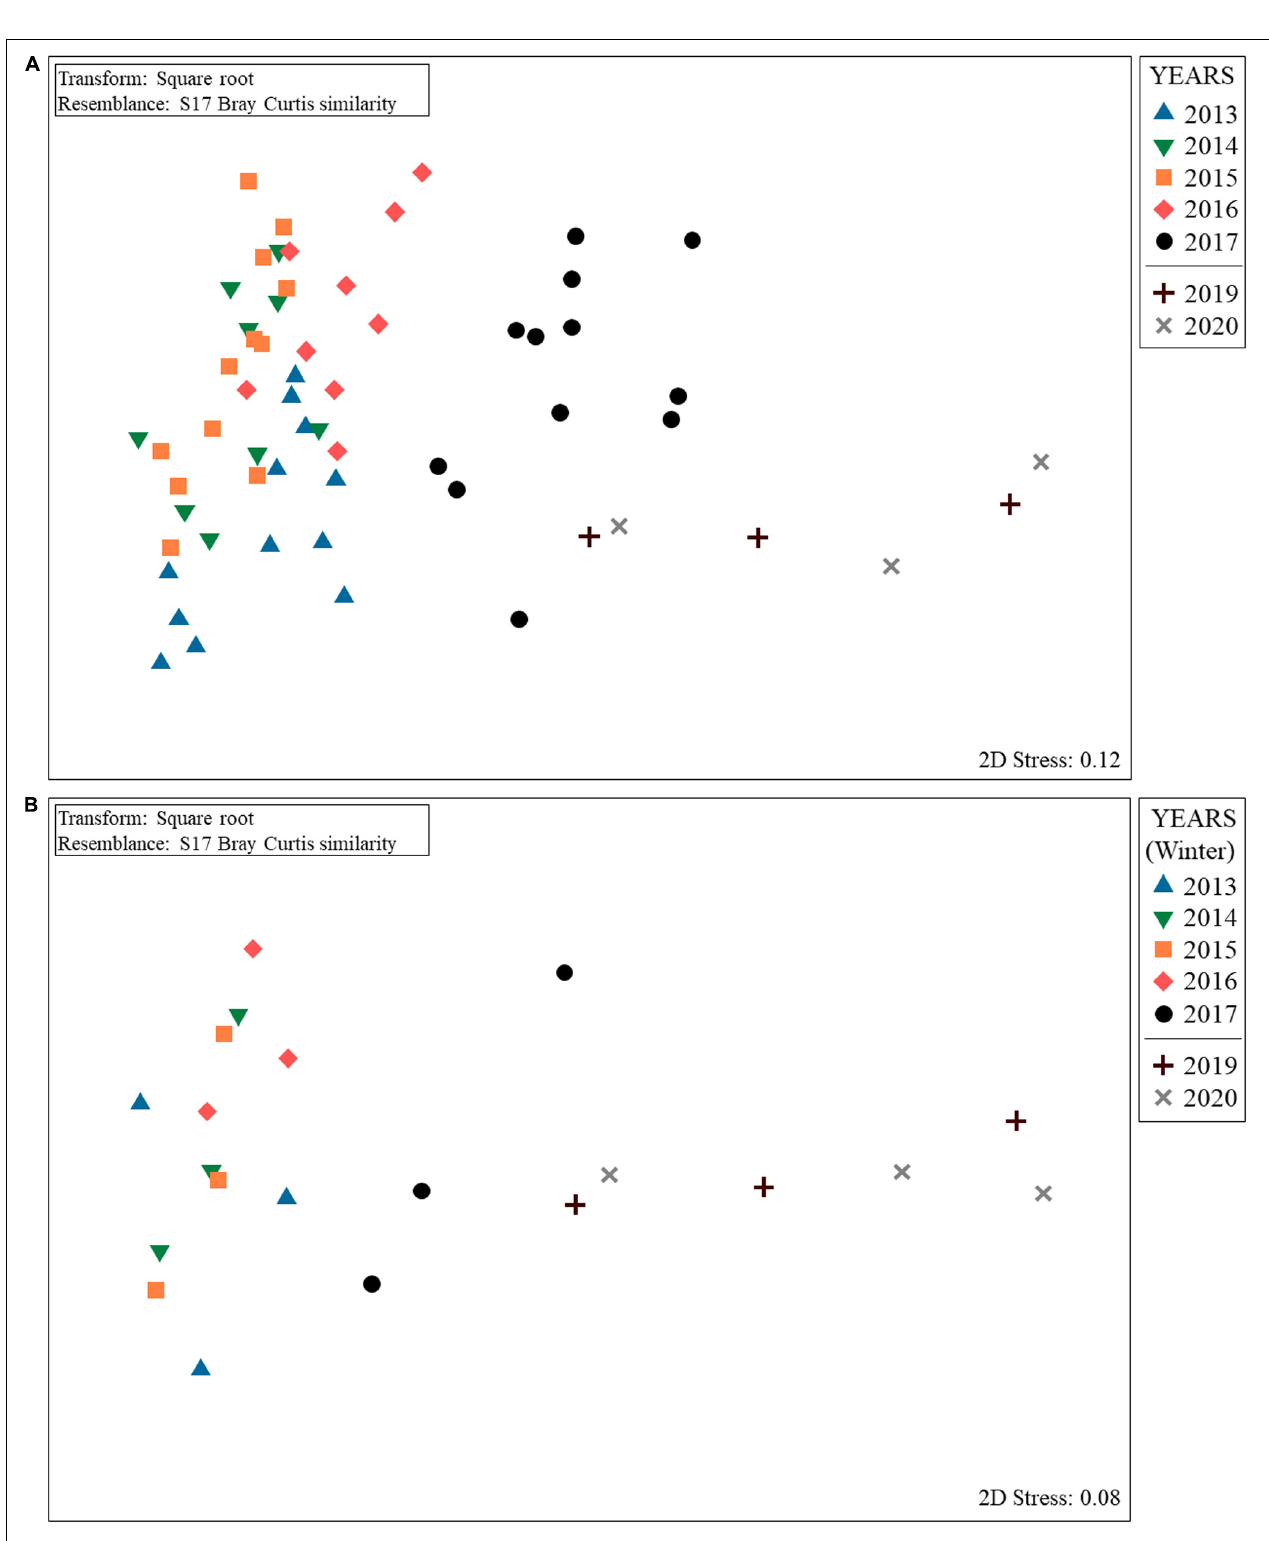
FIGURE 3 | nmMDS ordination for Tarifa Island SBPQ station showing the evolution of sessile communities from 2013 to 2020 (2018 data is missed) taking into account (A) intra-annual variability (i.e., seasons within each year) until 2017 and (B) only winter seasons.